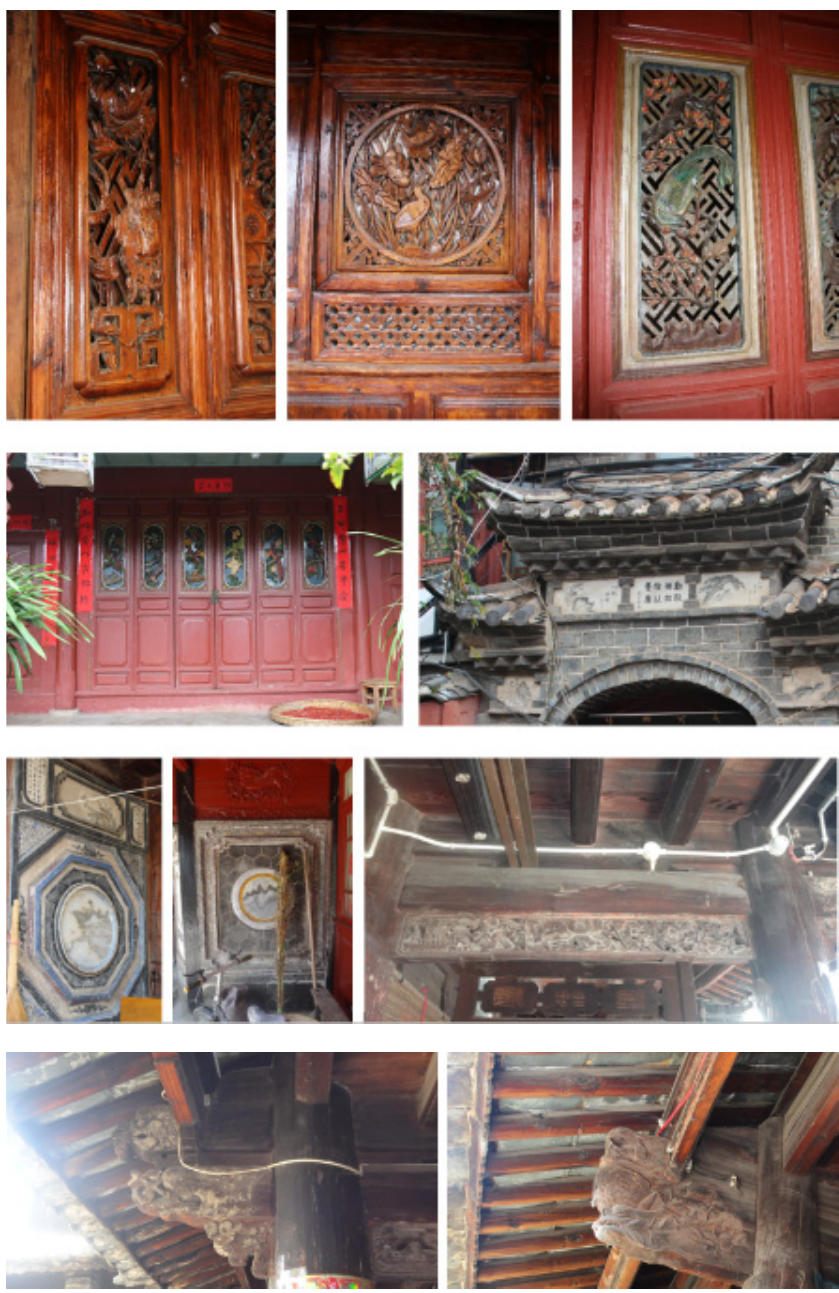
Figure 20. Engraved patterns, paintings, inlaid marbles with a theme of landscape or flora and fauna (photos by the first